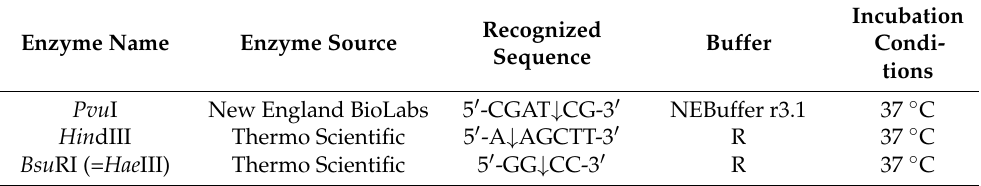
Table 2. The restriction enzymes used to study the LuFAD3A gene fragment from